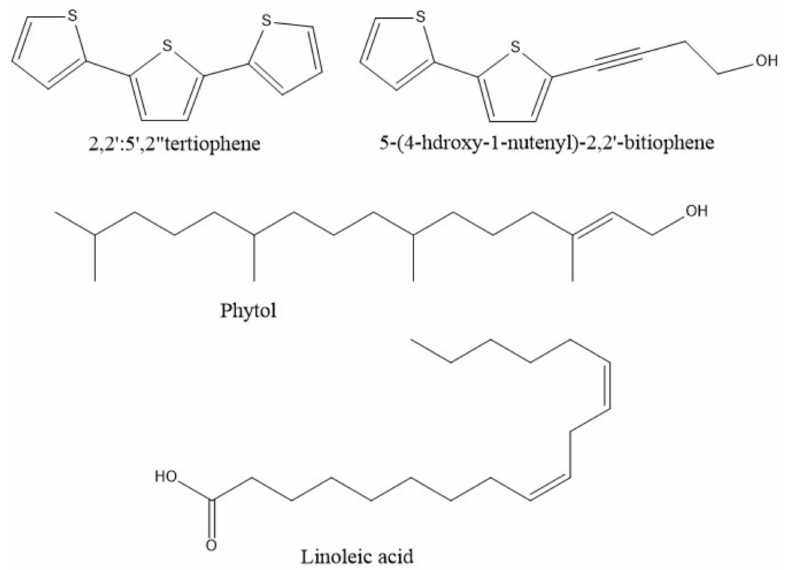
Figure 3. Components isolated from P. linaria and P. obscurum with antifungal activity. Juarez et al. [5] demonstrated the antifungal capacity of the essential oil of P. linaria on 11 strains, Aspergillus amylovorus (NRRL 5813), A . flavus (NRRL 3518), A . nomius (NRRL 13137), A . ostianus (NRRL403), Eurotium halophilicum (NRRL 2739), Eupenicillum hirayamae (NRRL 3587), E . hyrayamae (NRRL 3588), E . hyrayamae (NRRL 3589), E . hyrayamae (NRRL 3591), Penicillium cinnamopurpureum (NRRL 3118), and P . viridicatum var. ii (NRRL 5571). All strains were susceptible to P. linaria essential oil (MIC = 0.92 to 0.0069 µ g/mL), with the greatest effect observed on Aspergillus amylovorus (MIC = 0.0069 g/mL), and the least